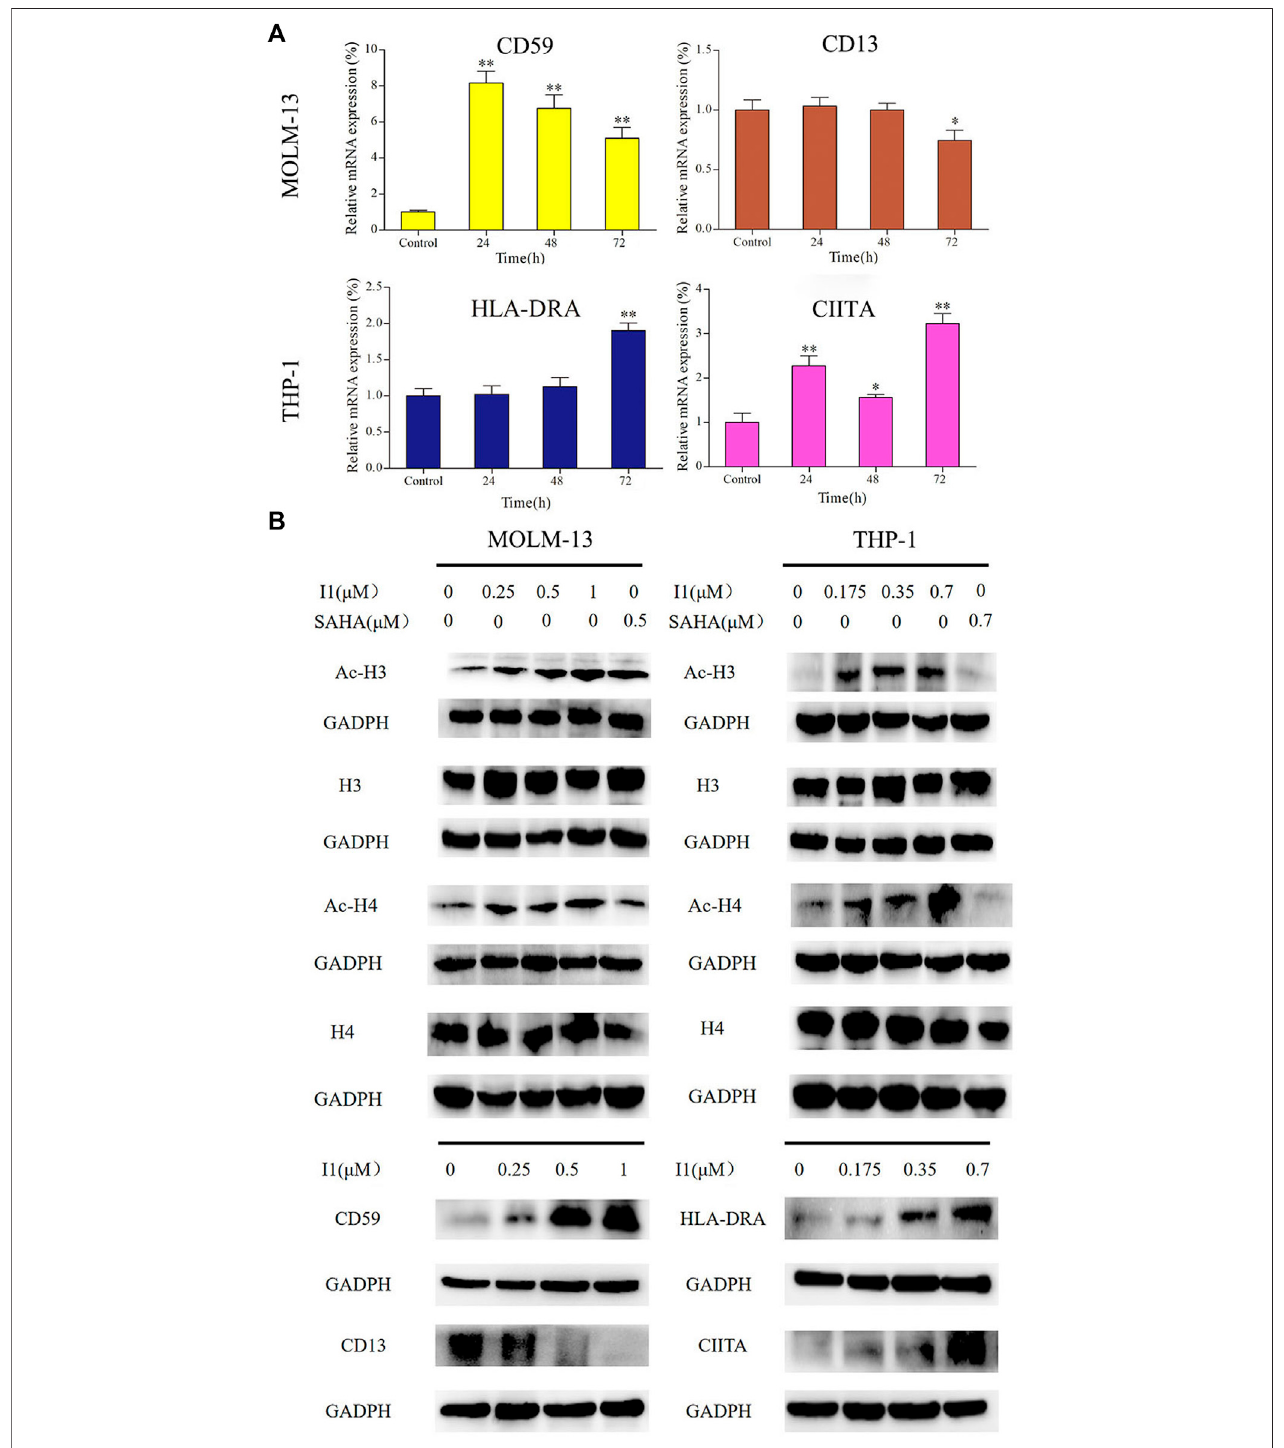
FIGURE 7 | The RT-PCR and Western blotting analysis of cell differentiation related genes in MOLM-13 and THP-1 cell lines. (A) The effects of I1 on the mRNA expression of CD59, CD13, HLA-DRA and CIITA evaluated by RT-PCR. MOLM-13 and THP-1 cells were incubated with 1, or 0.7 μ M I1 repectively, for 24, 48, or 72 h (B) H3, Ac-H3, H4, Ac-H4, CD59, CD13, HLA-DRA and CIITA protein levels measured by Western blotting analysis. (C) Graph bars show the protein expression visualized and quanti fi ed by AI600 imager. MOLM-13 were incubated with 0.25, 0.5, 1 μ M I1, or 0.5 μ M SAHA for 72 h. THP-1 cells were incubated with 0.175, 0.35, 0.7 μ M I1, or 0.7 μ M SAHA for 72 h(* p < 0.05, ** p < 0.01).